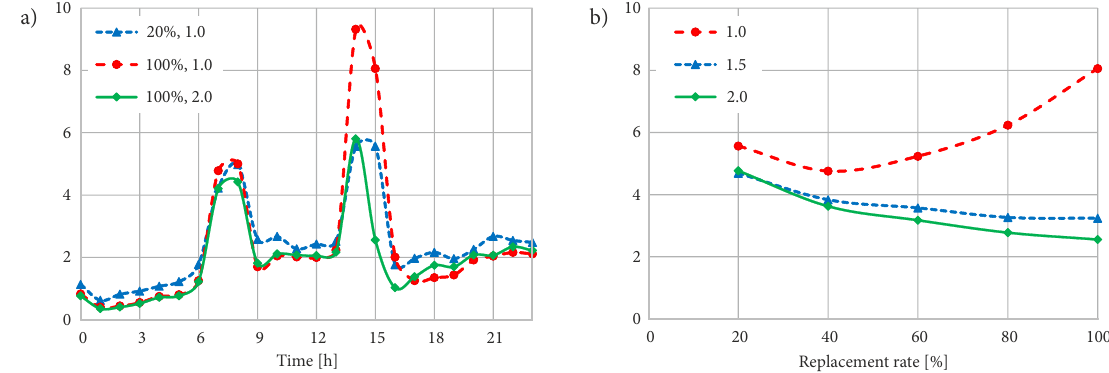
Figure 6. Passenger wait times: a – hourly averages for selected simulation cases; b – peak-hour averages